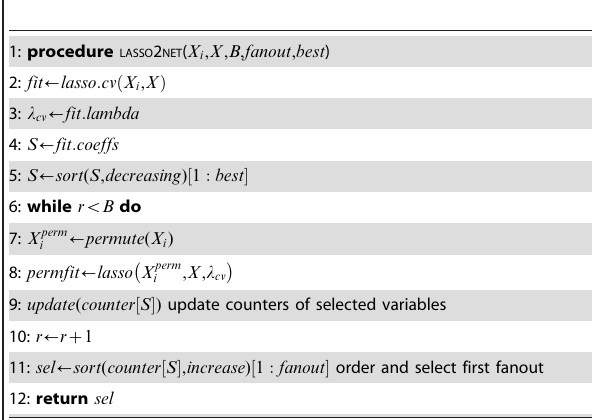
Table 1. Algorithm of the variable selection and permutation-based stability